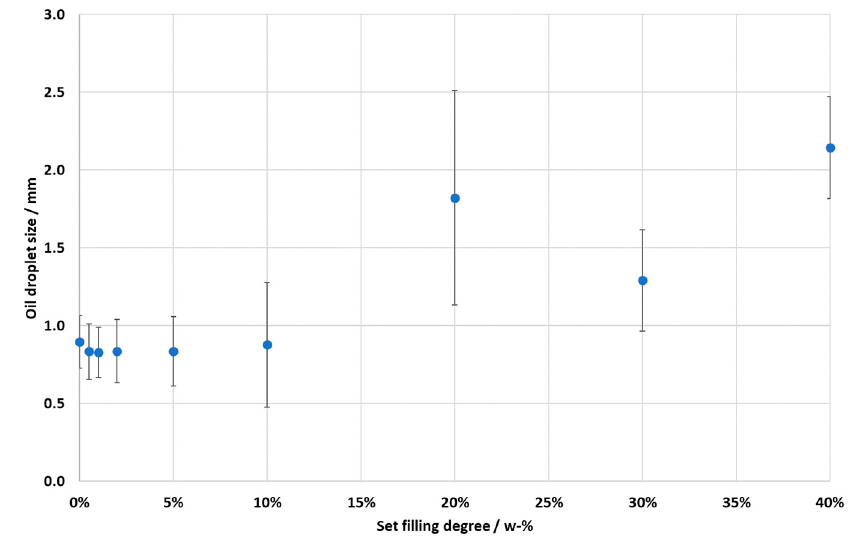
Figure 7. Plot of mean oil droplet sizes versus filling degrees. The droplet sizes remained constant up to the 10% filling degree before increasing.